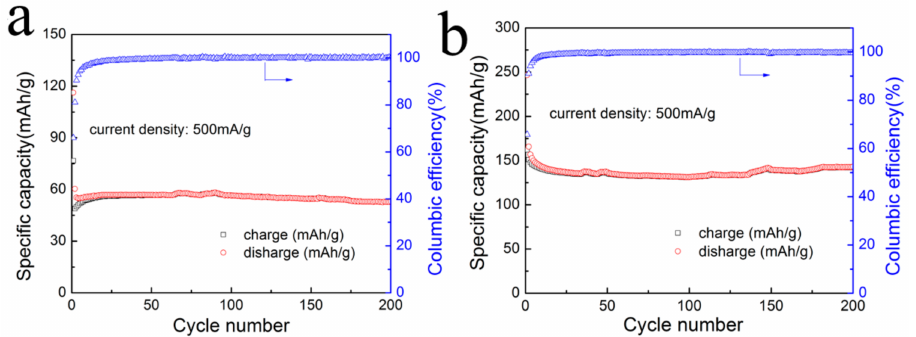
Figure 7. Cycling performance of ( a ) Ti 3 C 2 T x and ( b ) the RGO/Ti 3 C 2 T x nanocomposite at a current density of 500 mA/g.